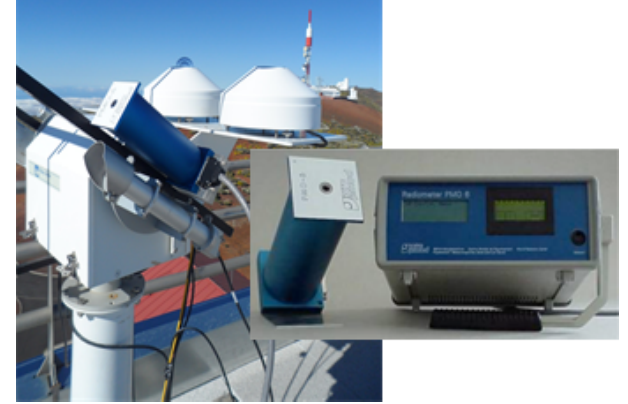
Figure 6. Absolute cavity radiometer (PMO6) mounted on the IZA BSRN Sun tracker during a calibration